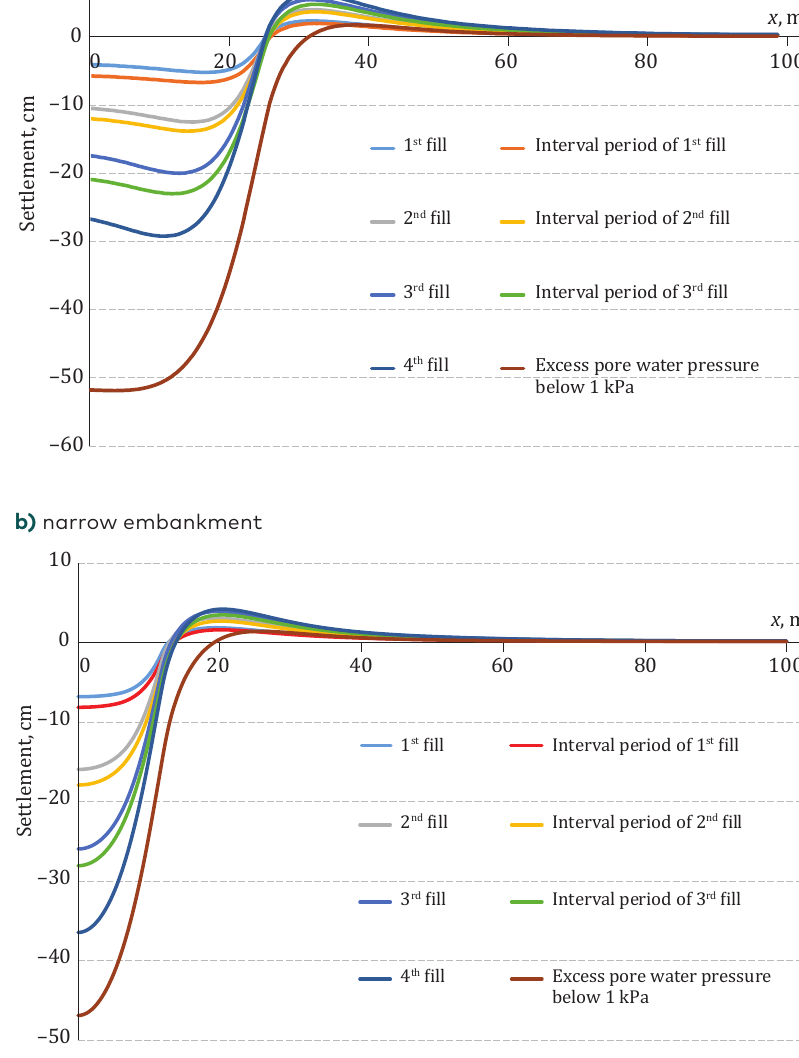
Figure 5. Settlement transverse distribution of ground